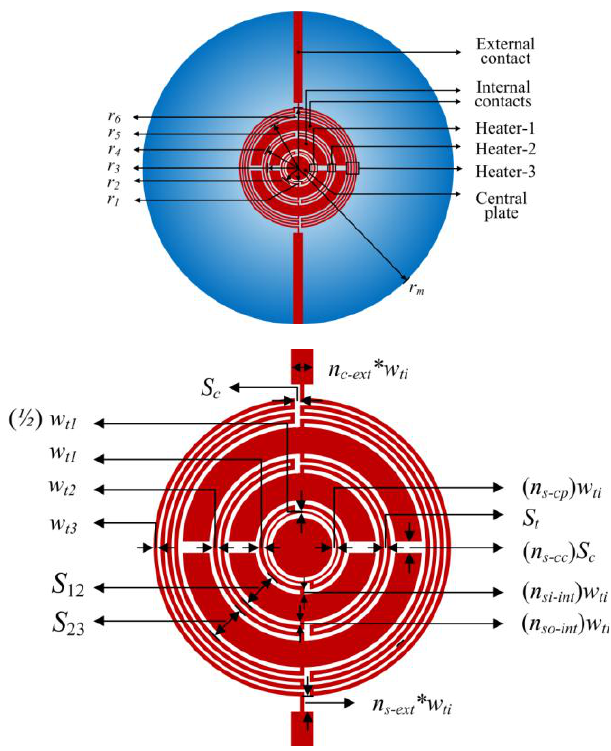
Figure 4. Micro-hotplate with three-heater geometry ( top ) and zoom of the central part of micro-hotplate ( bottom ) (not to scale).